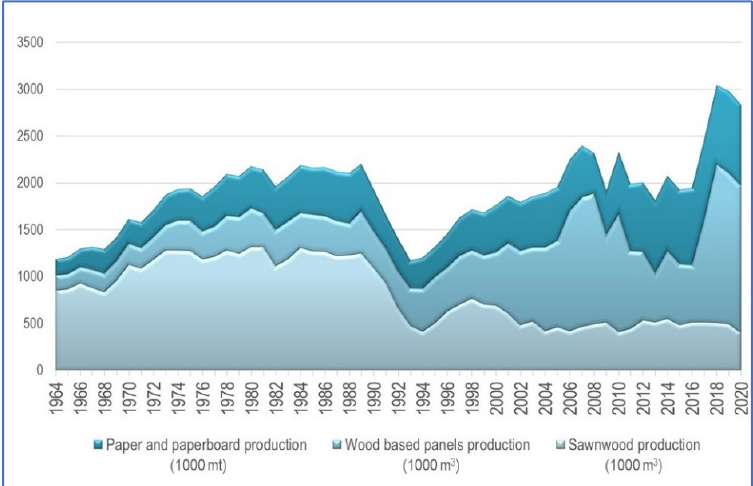
Figure 5. Production of semi-finished wood product types in time period of 1964–2020.